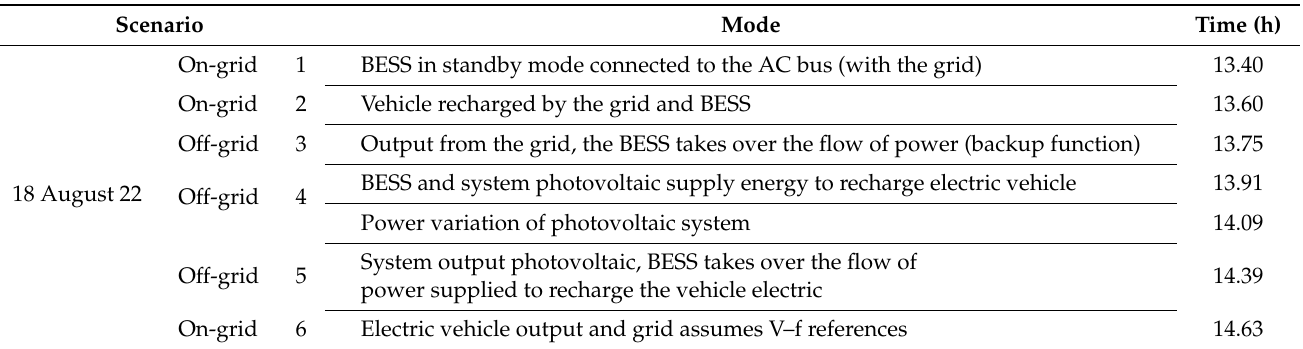
Table 2. Specifications of RoadMap of